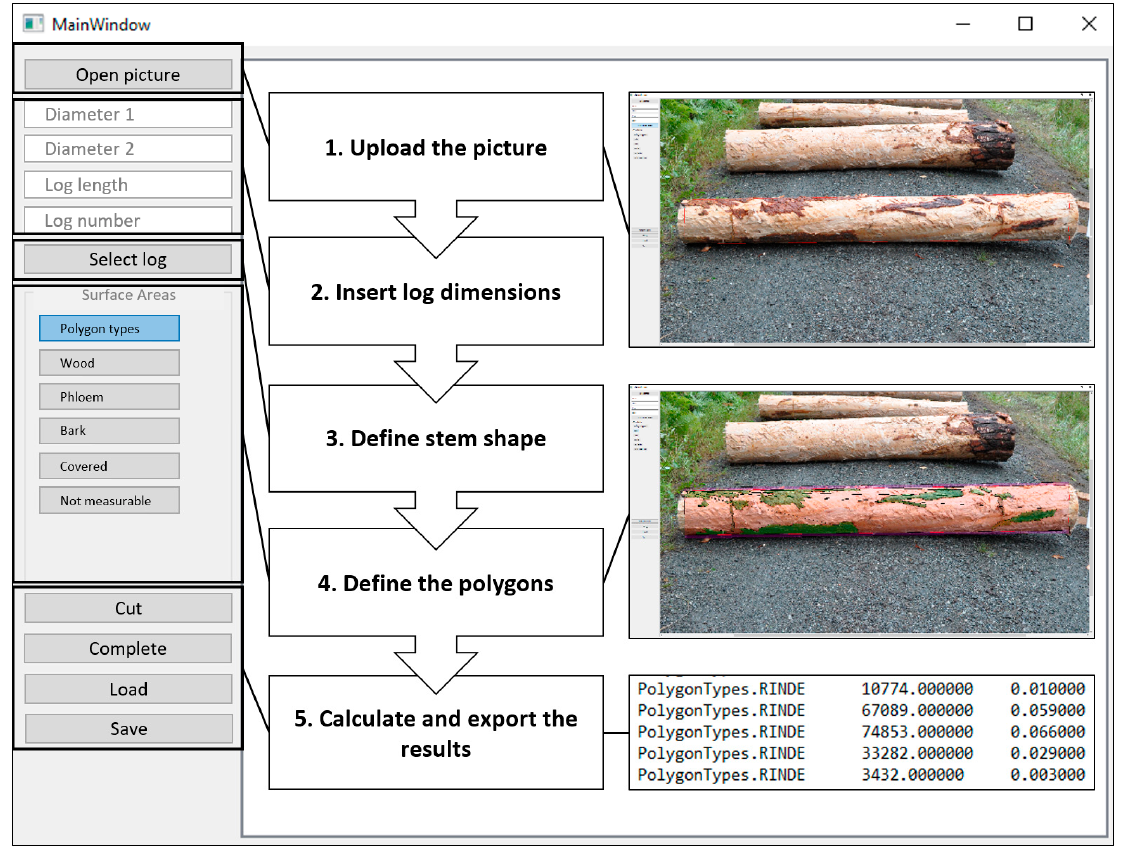
Figure 1. Schematic chart of the operating principle and working steps for the Stemsurf software.